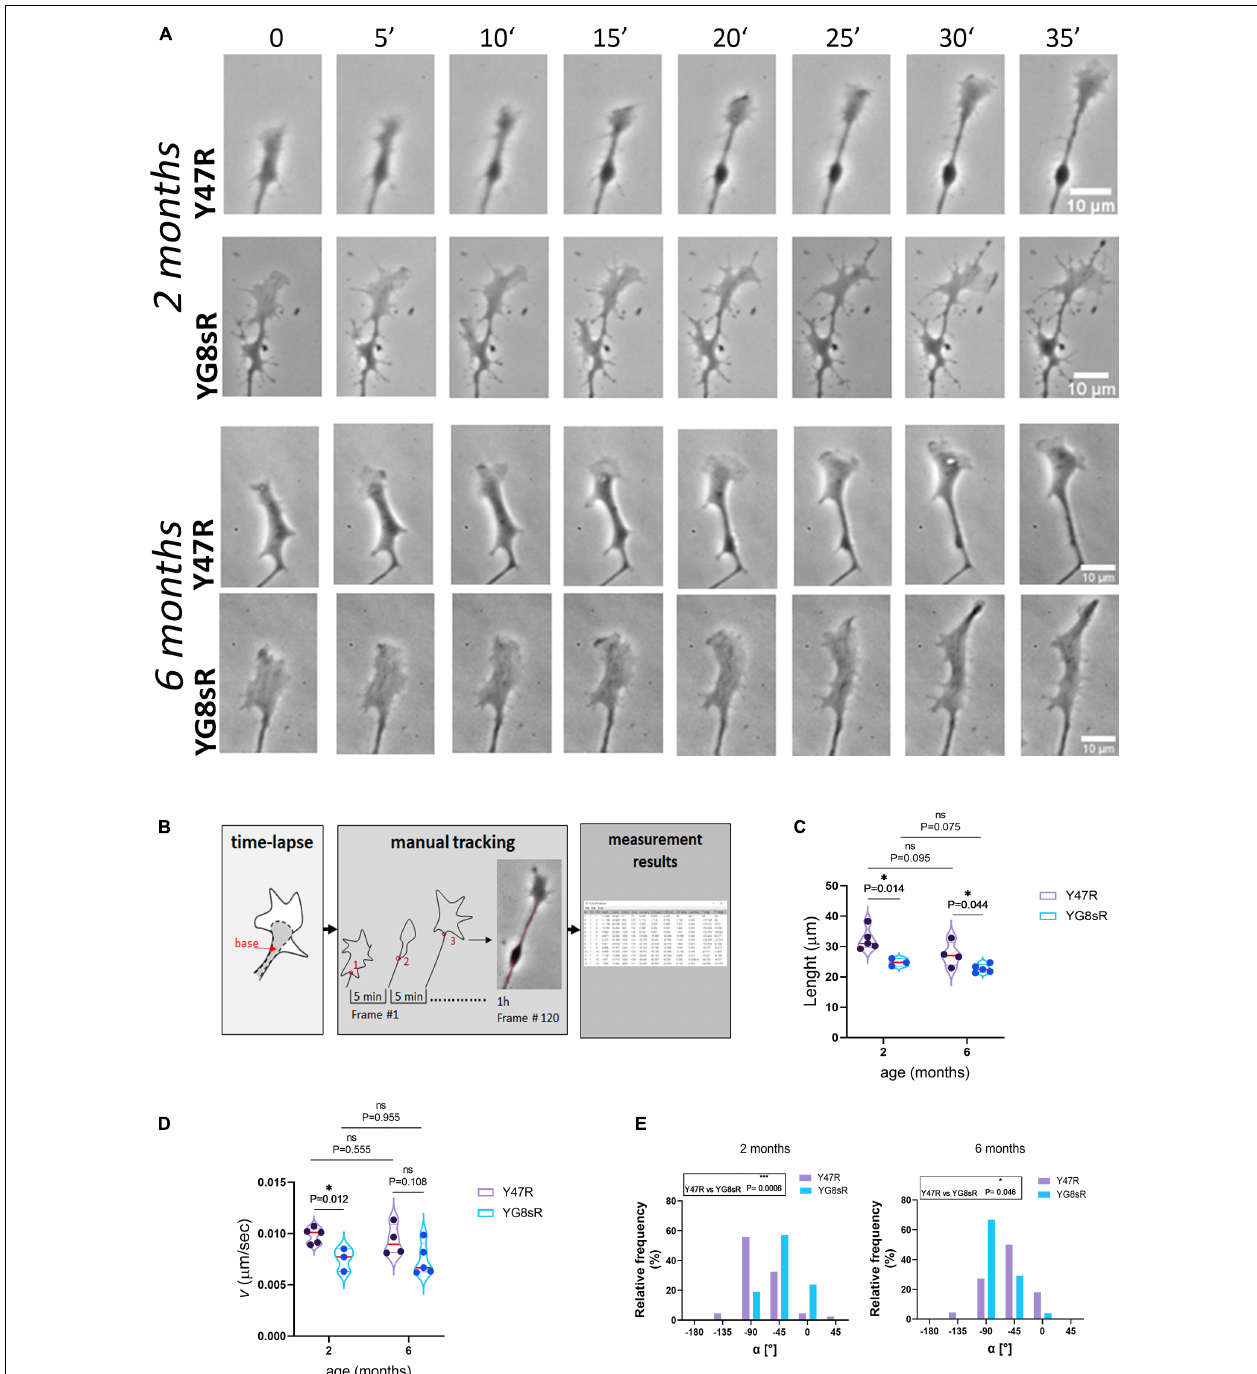
FIGURE 2 | Neurites of frataxin-deficient neurons of the YG8sR mouse grow slower and with not defined trajectories. (A) Representative sequences of frames 5 min apart from a time-lapse movie of control and YG8sR- growth cone (GC) at 2 and 6 months of age. Scale bar, 10 µ m. (B) Workflow to obtain the motion tracking with the MTrackJ plugin. First, rotation of the movie to a fixed position to start. Secondly, selection of the points of the track with the points located at the center of the base of the growth cone (red points) and in frames 5 min apart; and Third, obtention of the final measurement results. (C–E) Violin plots show the average Length (C) and velocity (D) data’s general distribution. (E) Graphical representation of the frequency distributions for the GC’s average turning angles ( α [ ◦ ]) at 2 (left, Y47R: 42 growth cones from n = 3, YG8sR: 21 growth cones from n = 3) and 6 months of age (right, Y47R: 19 growth cones from n = 3, YG8sR: 24 growth cones from n = 3). The GCs of YG8sR neurons travel fewer distances with lower speed and distinctive turning angles than the controls at 2 ( ∗∗∗ : exact P -value = 0.0006) and 6 ( ∗ : exact P -value = 0.046). The median (red horizontal bar) and interquartile (25 and 75%, colored horizontal bars) are shown. Statistical significance was determined using the Holm–Sidak method for length and velocity and using the Mann–Whitney test for the turning angle.